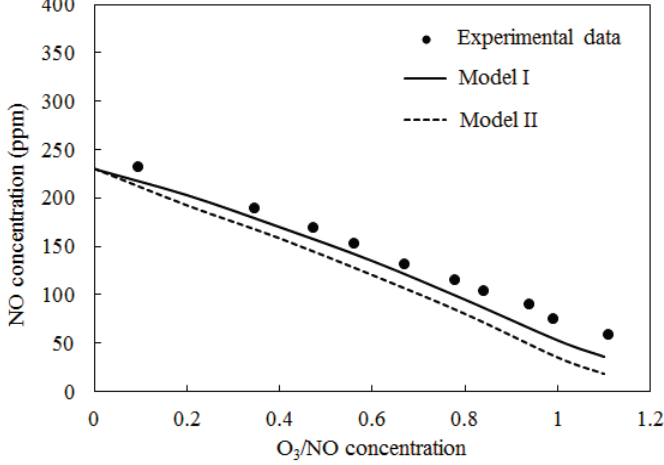
Figure 5. Variations of NO concentration with O 3 /NO concentrations at T = 200